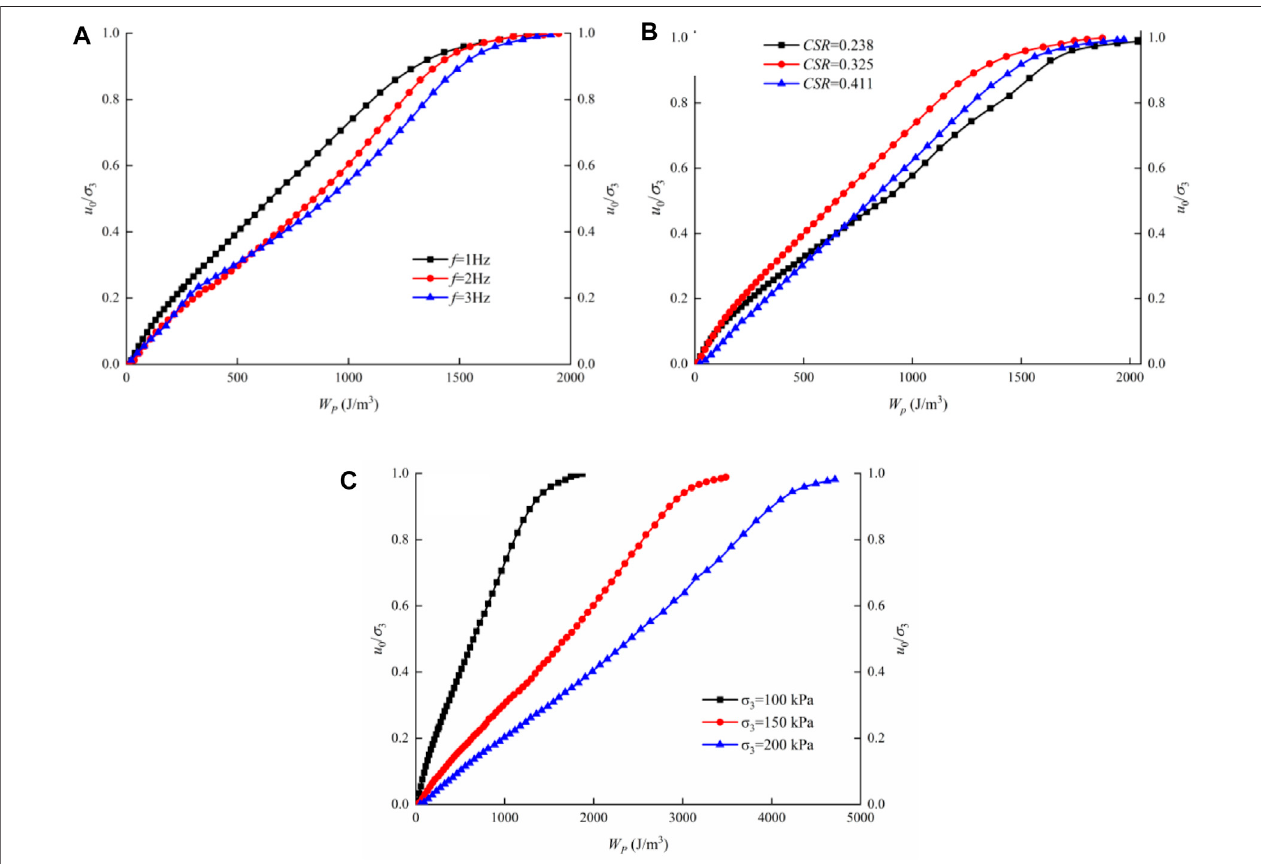
FIGURE 11 | Relation between pore-water pressure ratio and cumulative dissipated energy under different frequencies (A) , cyclic shear stress ratios (B) and con fi ning pressures (C) .